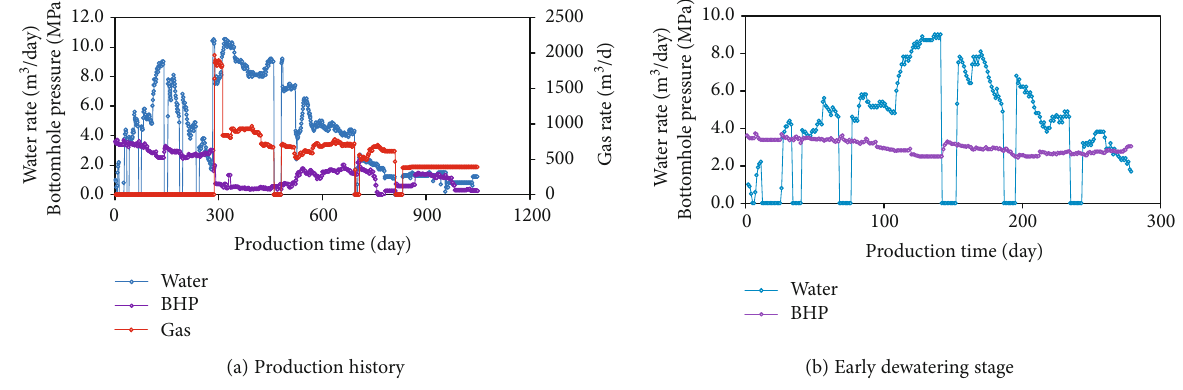
Figure 11: The production history of the well ZY-n (Qinshui Basin,